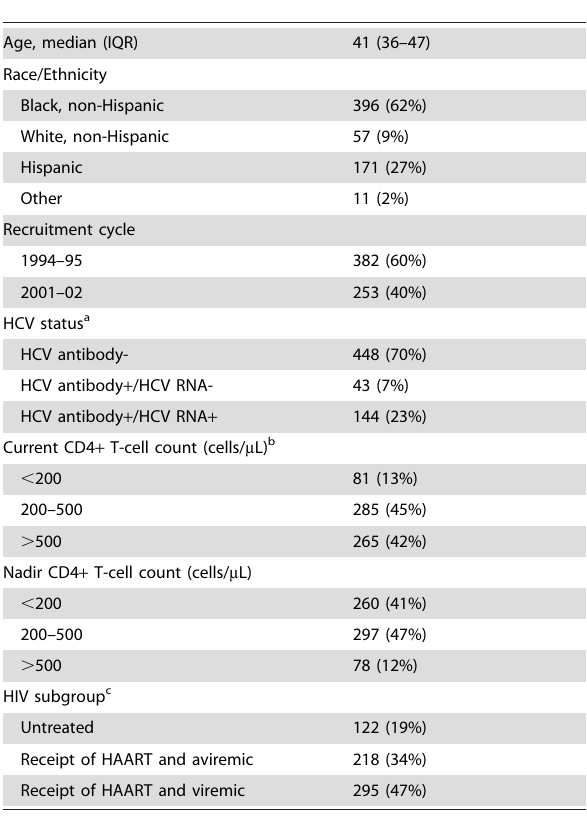
Table 1. Characteristics of the study women